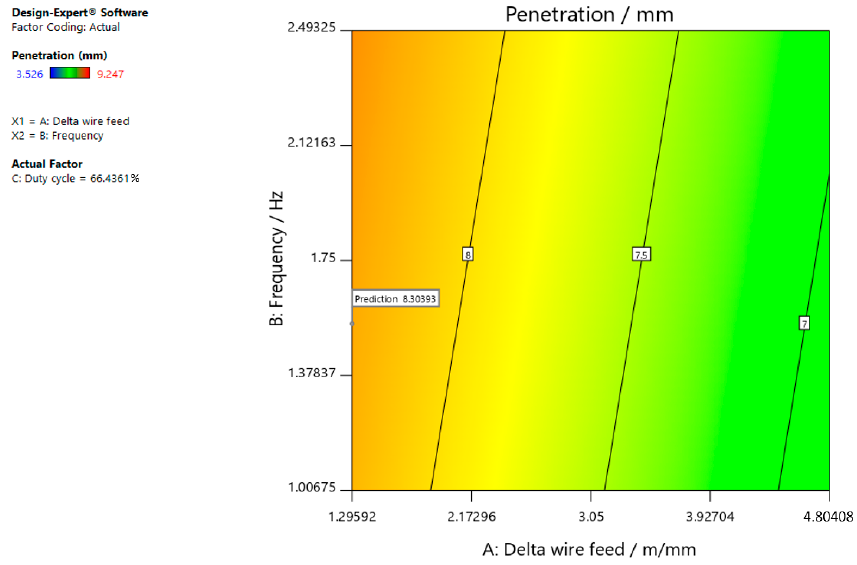
Figure 13. Optimal parameters for achieving as much penetration as possible.